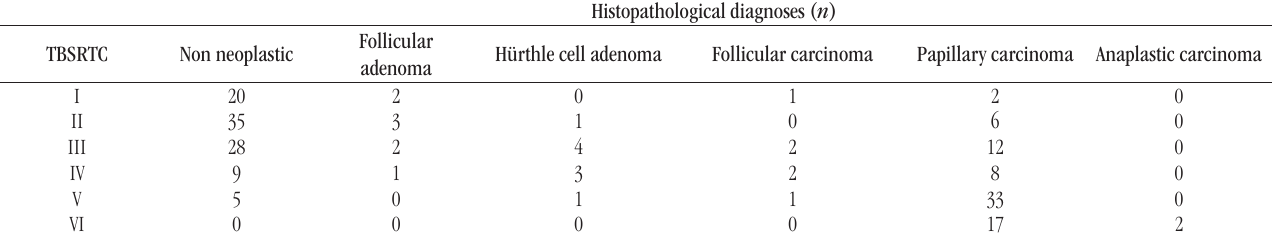
taBLE 2 − Correlation between cytological (FNA) and histological diagnoses of the thyroid Histopathological diagnoses ( n